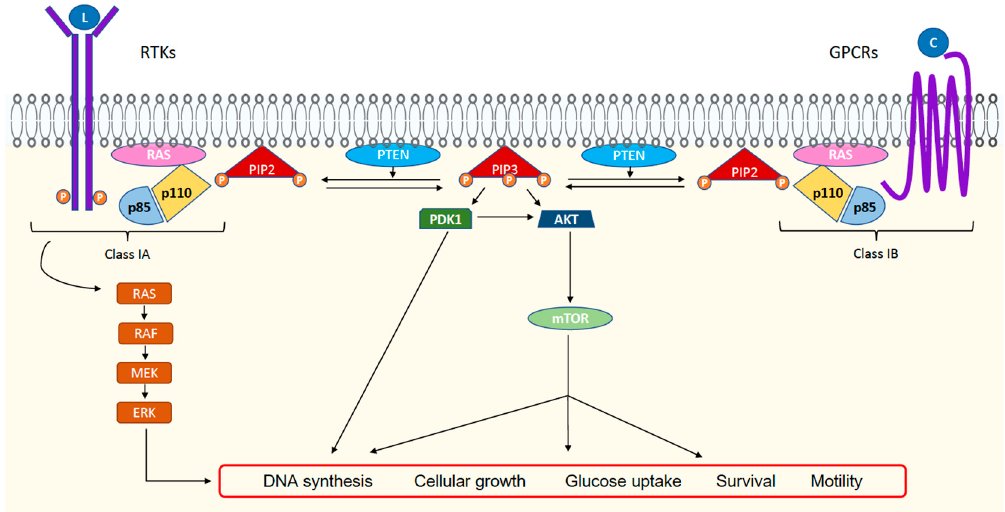
Figure 1. Summary diagram of the PI3K pathway and cellular activation pathways.